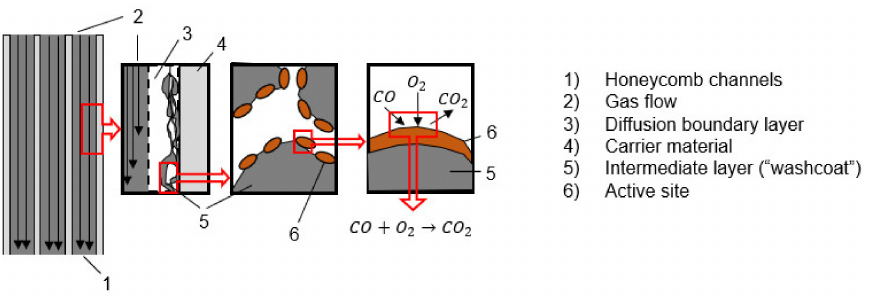
Figure 16. Construction design of a honeycomb catalyst and characteristics of a catalytic reaction. Own figure based on [65].